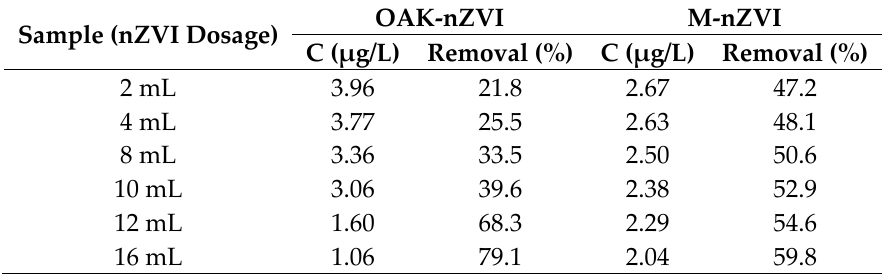
Table 2. PO 43 − (5.06 mg/L) removal efficiencies when in a mixture with As(III) using OAK-nZVI and